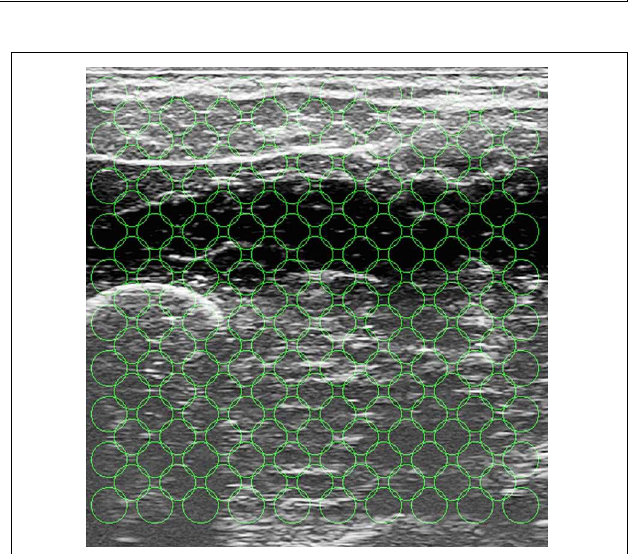
of rest. Five repetitions per finger are induced. In the graded phase (GR1) the subjects must exert force following a squared sinusoidal pattern. (B) Forces as measured by the force sensor during the experiment for a typical subject.